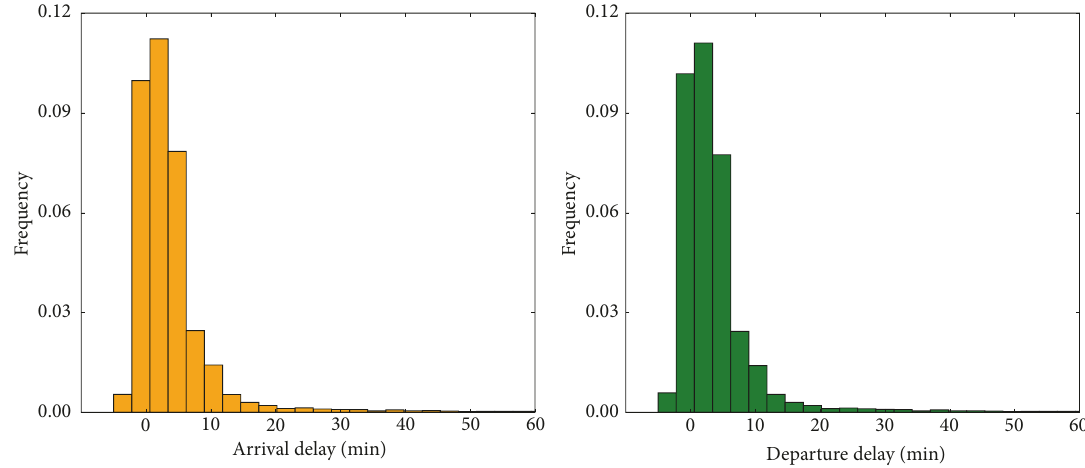
Figure 2: Arrival and departure delay distribution of HSW station.